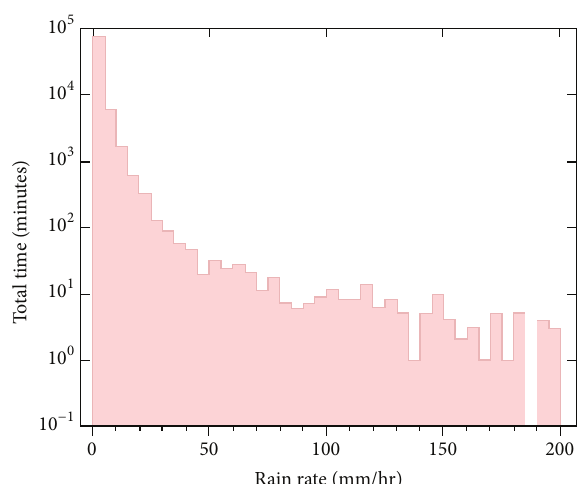
Figure 4: Histogram of rain rate calculated using 84,574 samples of 1 min DSD after quality